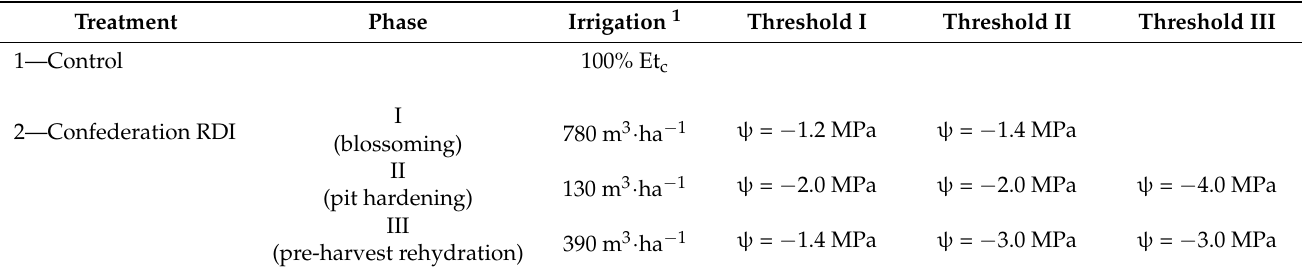
Table A1. Irrigation doses and stress levels in the irrigation treatments.